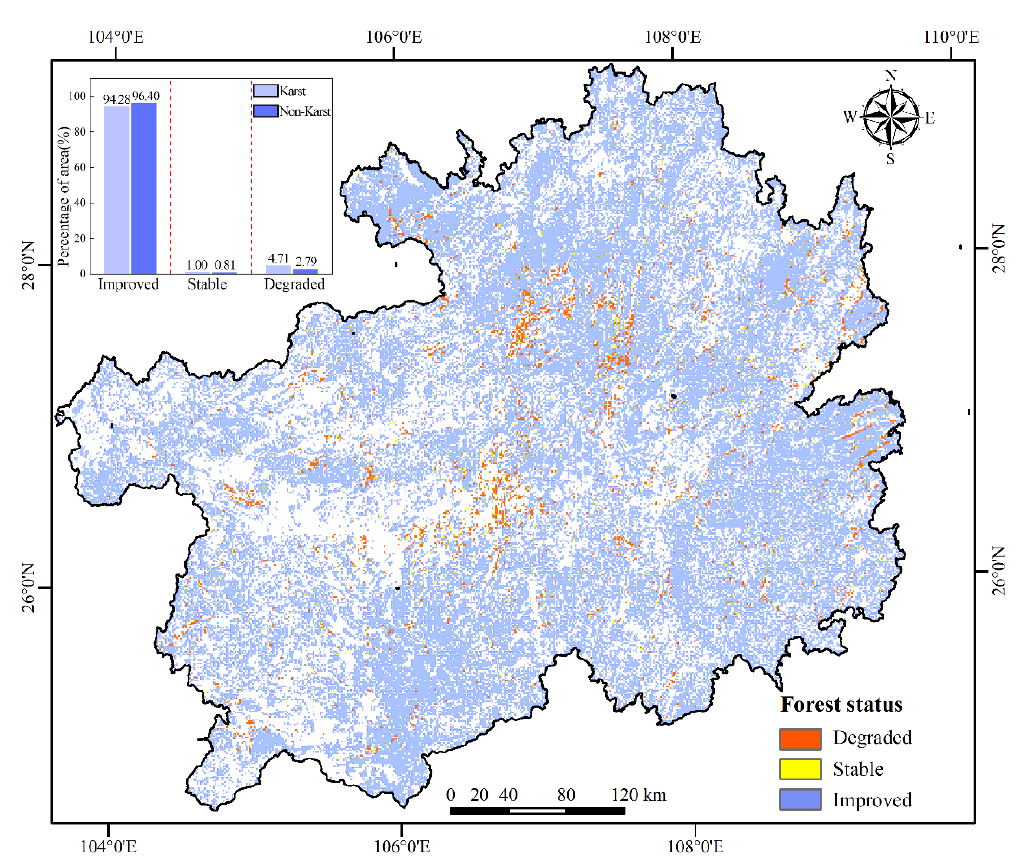
Figure 3. Trends in forest coverage variation from 2005 to 2018.